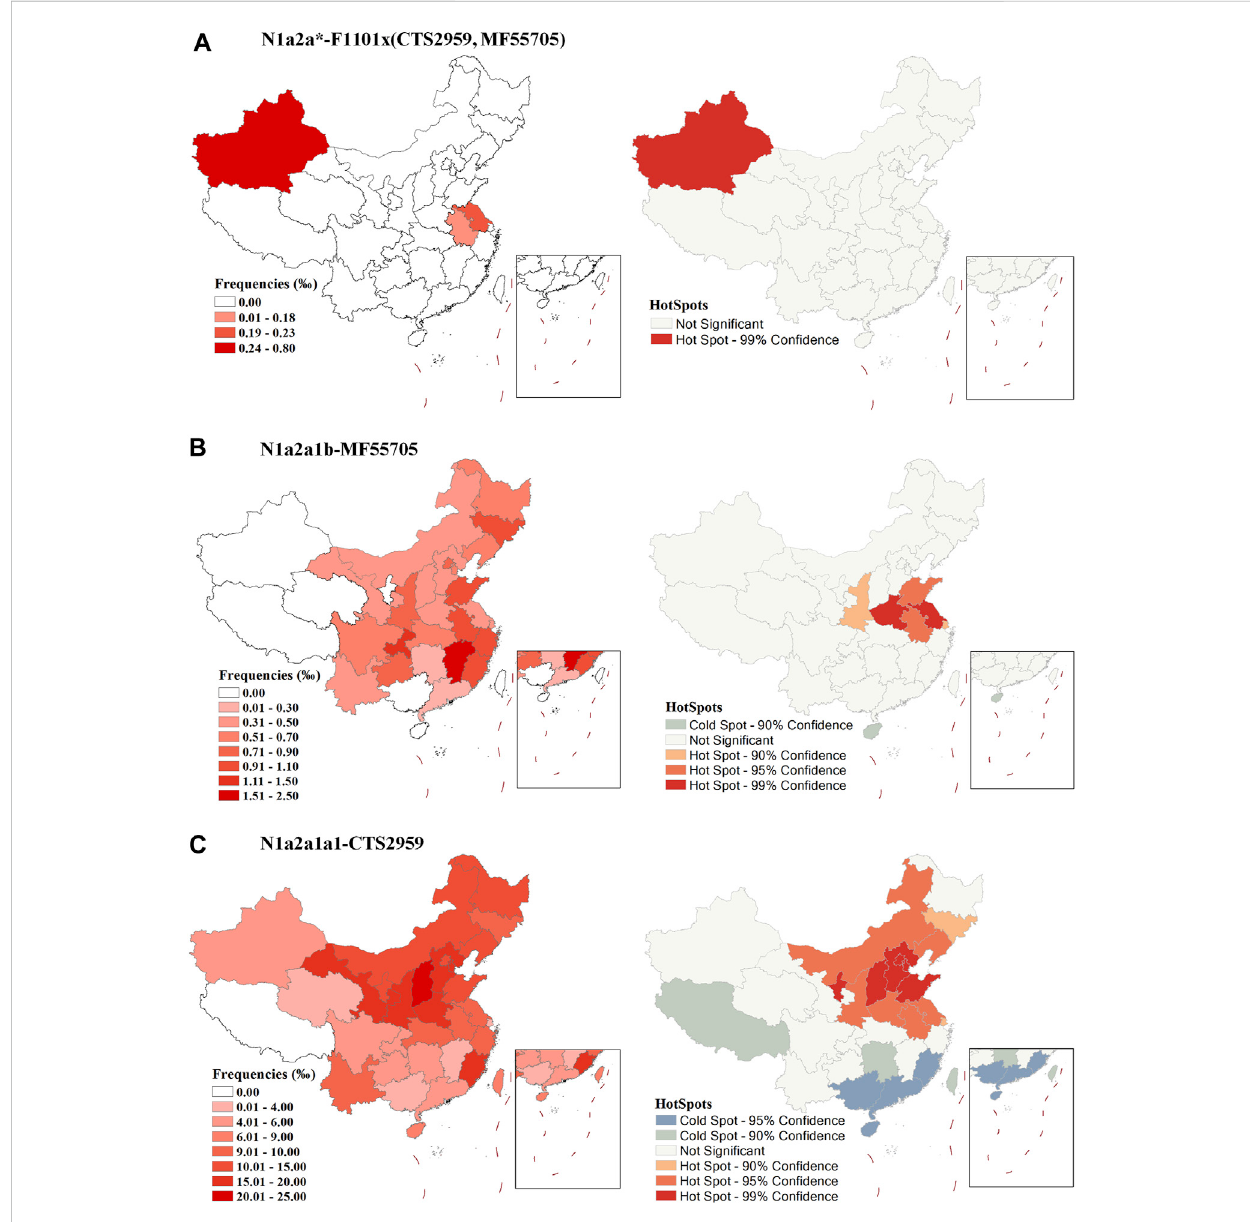
FIGURE 2 Geographic distribution of sub-branches of N1a2a-F1101 and results of a spatial autocorrelation analysis of frequencies. (A) : N1a2a*- F1101×(CTS2959,MF55705), (B) : N1a2a1b-MF55705, (C) :